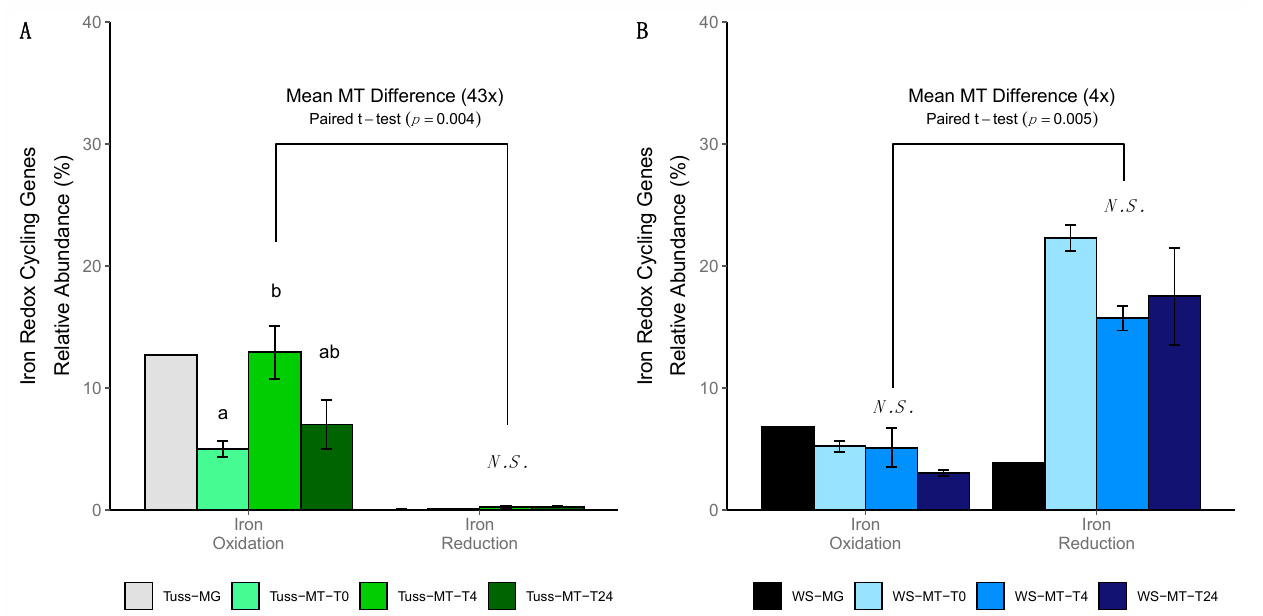
Figure 5. Barplot of iron redox cycling gene expression based on the mean relative abundance of iron oxidation and iron reduction genes at each sampling time point in ( A ) tussock tundra and ( B ) wet sedge tundra communities (error bars represent standard deviation of the mean). Letters indicate significant differences in mean pairwise similarity between sampling time points in each iron redox cycling functional category (ANOVA; p < 0.05), with non-significant differences between sampling time points indicated as N.S. The relative abundance of each metagenome (MG) iron redox cycling functional category is provided for reference only and was not incorporated in the pairwise analysis.